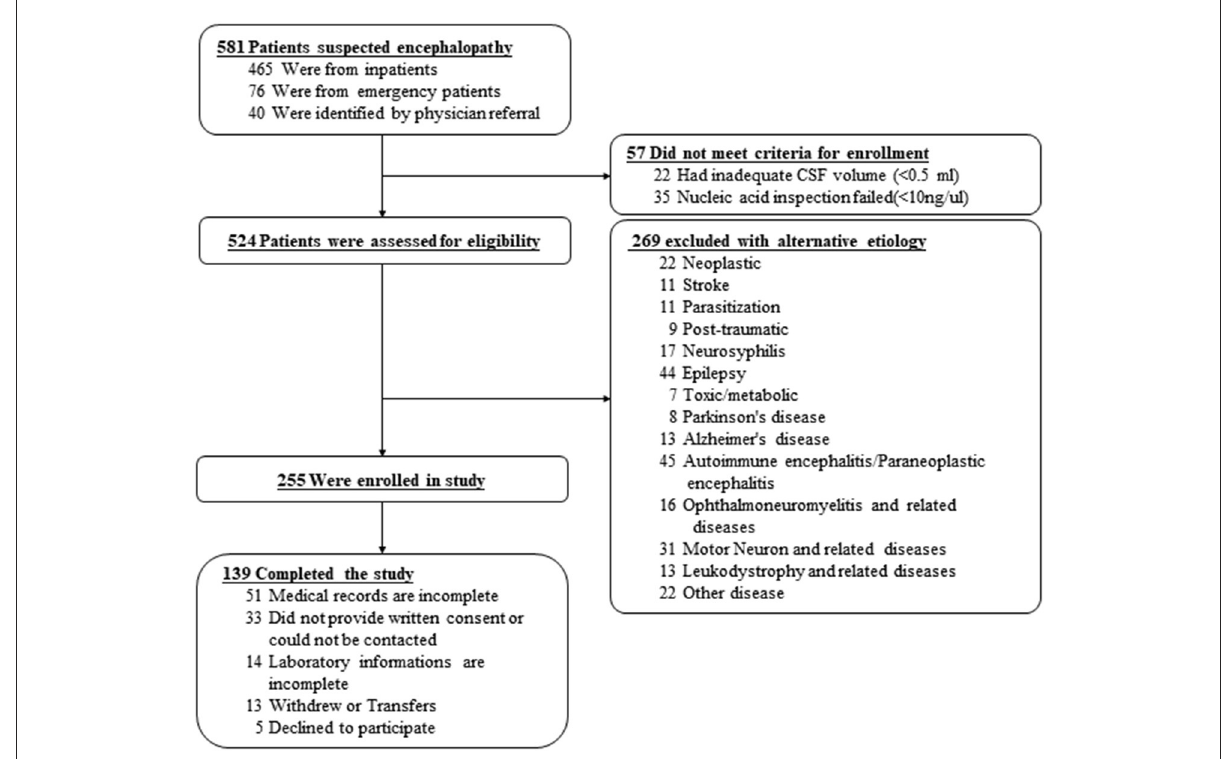
FIGURE1 The flowchart of the